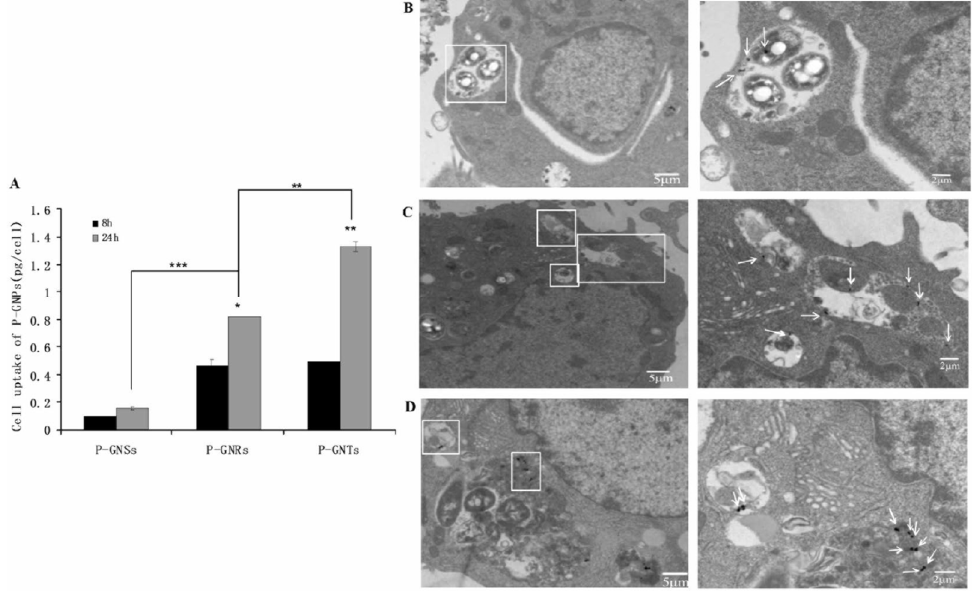
Figure 2. Cellular uptake of P-GNPs ( A ) and transmission electron microscopy images of RAW 264.7 after 24 h of incubation with P-GNSs ( B ), P-GNRs ( C ), P-GNTs ( D ). Data represent mean ± SEM ( n = 3). Statistical significance is represented by * p < 0.05, ** p < 0.01, *** p < 0.001 [46]. Reproduced from